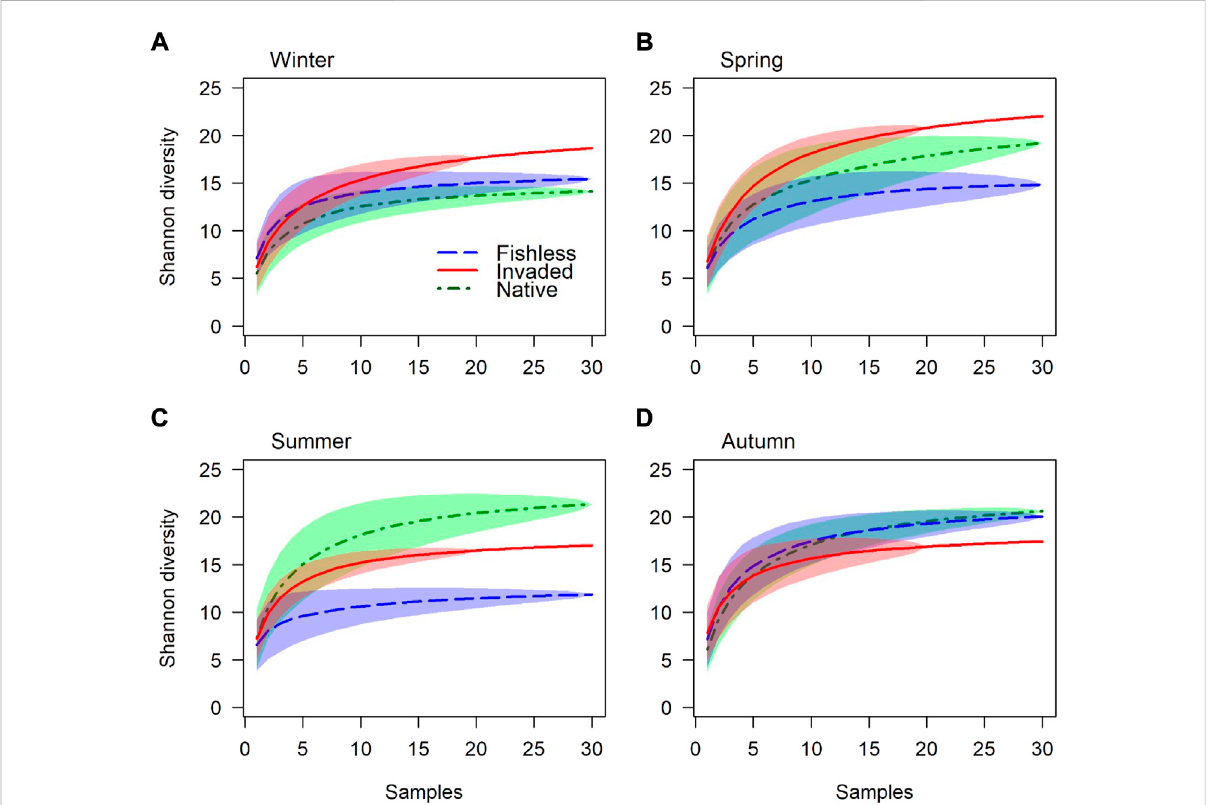
FIGURE 5 Macroinvertebrate Tsallis ’ s accumulation curves equivalent to Shannon diversity, for river reaches without fi sh, invaded by trout, and inhabited bynative fi sh,for (A) . Winter, (B) .Spring, (C) . Summer and (D) .Autumn.Standard deviationis indicatedby shadedareas. Species richness between 20 and 30 samples in the invaded reach were extrapolated from the Lomolino